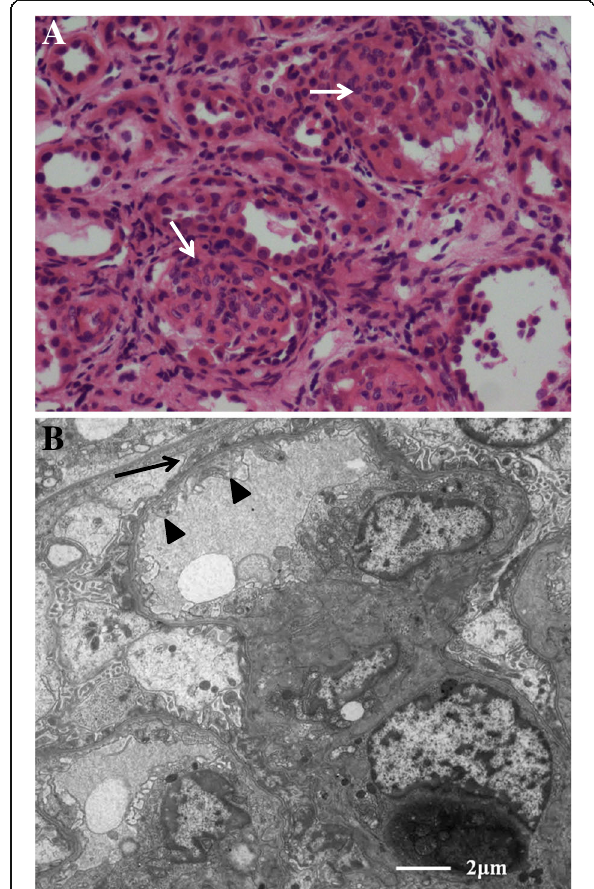
Fig. 3 Renal pathological findings from Case II-1 at 2 weeks of age. a About half of the glomeruli showed segmental sclerosis (arrows). Hematoxylin and eosin staining, original magnification × 400. b Ultrastructurally, the glomerular basement membranes exhibit normal thickness, but show focal subendothelial widening (arrowheads). No electron-dense deposits were found. Epithelial cell foot processes show focal marked effacement (arrows). Original magnification ×